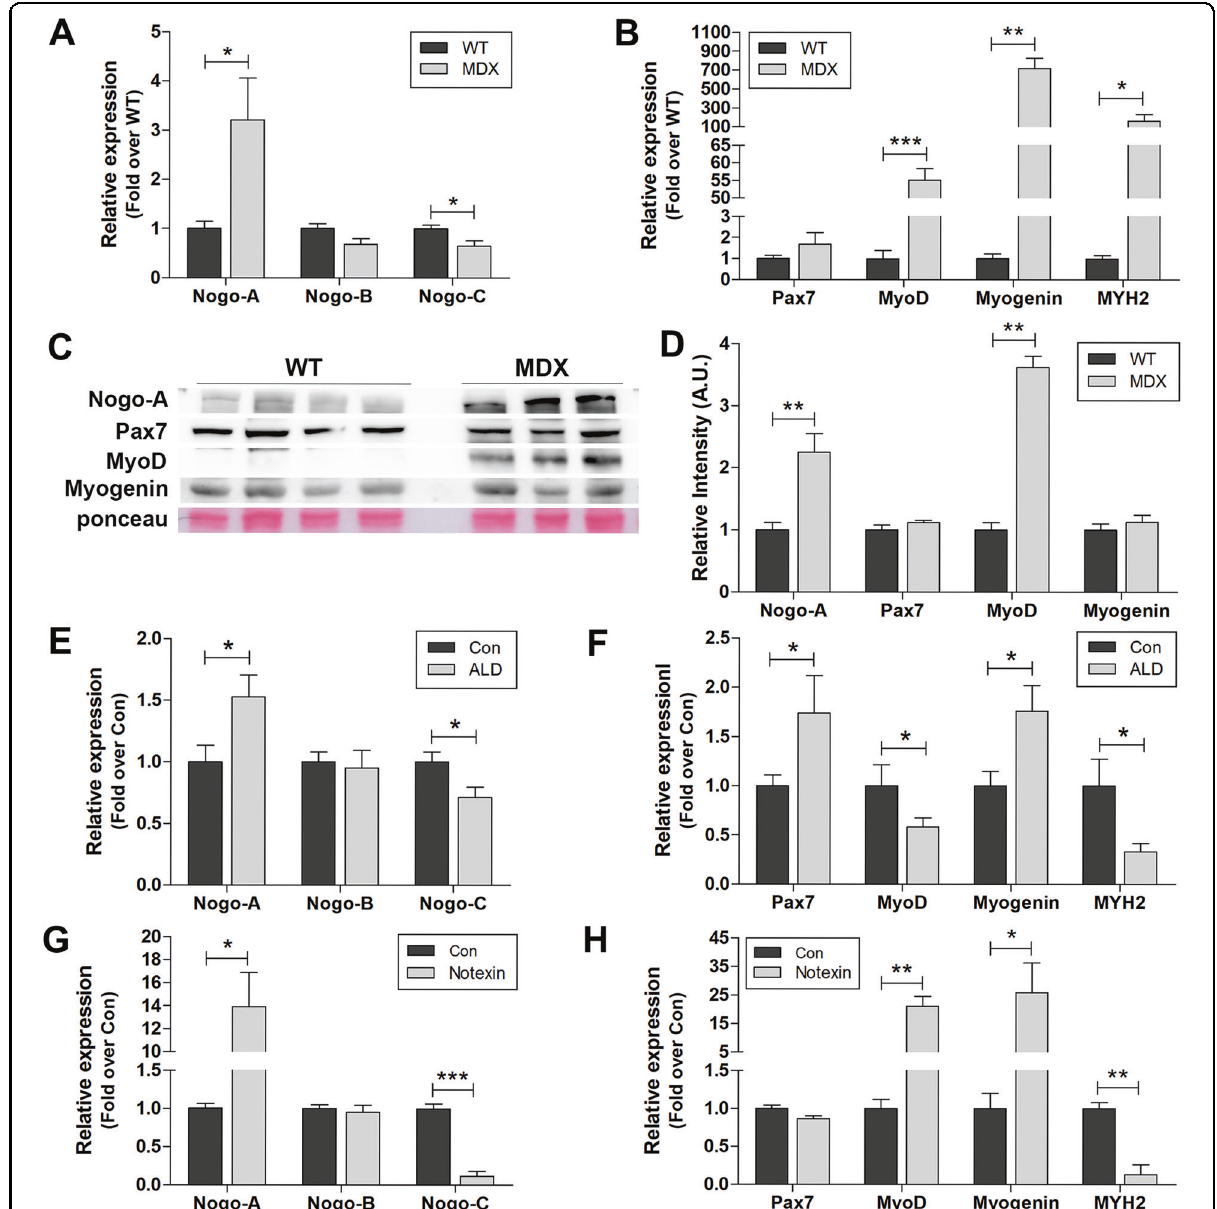
Fig. 2 Altered expression of Nogo and myogenic factors in animal myopathy models. A , B qRT-PCR analysis for indicated genes in muscle samples from 12-week-old wild-type (WT) ( n = 4) and mdx ( n = 3) mice. Mean ± SEM. * p < 0.05, ** p < 0.01, *** p < 0.001. C WB analysis of indicated proteins in muscle extracts from 12-week-old WT ( n = 4) and mdx ( n = 3) mice. Molecular weights (kDa) are indicated. D Quantitative assessment for protein ( C ) using the NIH ImageJ software. Mean ± SEM. ** p < 0.01. E , F qRT-PCR analysis for indicated genes in muscle samples from control (Con, n = 6) mice in a model of alcoholic liver disease (ALD) ( n = 8). Mean ± SEM. * p < 0.05. G , H qRT-PCR analysis for indicated genes in muscle samples from control (Con, n = 3) and notexin-injured mice (8-week-old C57BL/6, 50 ng/gastrocnemius, 3 days post injury, n = 3). Mean ± SEM. * p < 0.05, ** p < 0.01, *** p <